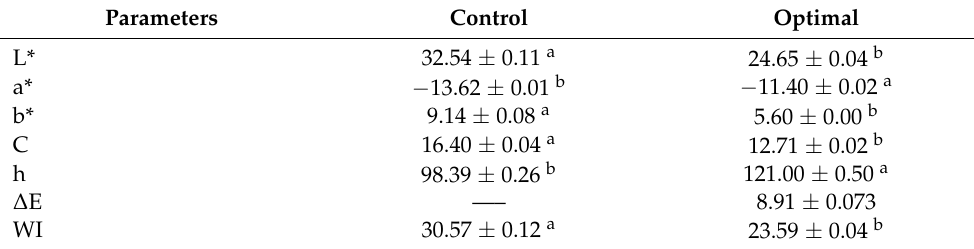
Figure 8. L*, a* and b* of control and optimal snacks (The top row of the optimal sample contains SP and the bottom row of the sample contains no SP). Table 8. Color parameters of control and optimal